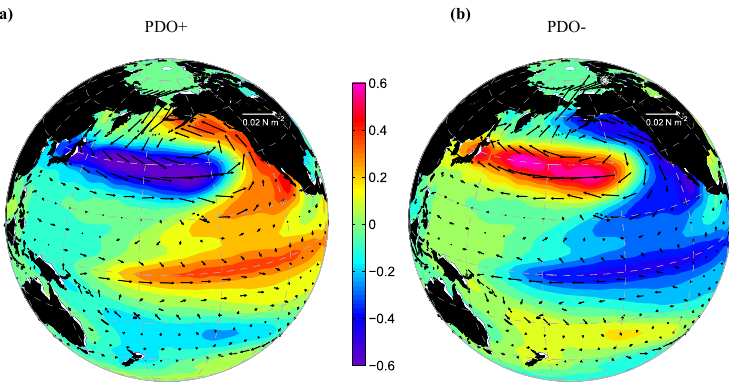
Figure 7. PDO modulation of winds and sea surface temperature in the Pacific (Zhang and Delworth, 2015). Regression of SST ( ◦ C) and surface wind stress (Nm 2 ) against the PDO index. Note the northward direction of the wind stress in the central northern part of the Pacific during the negative phase of the PDO (b) . Winds from the Siberian Shelf have an eastward direction and reach Melville Island during negative PDO. Reproduced with permission from the American Meteorological Society